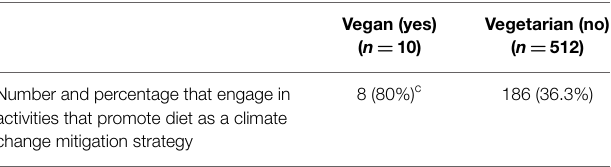
TABLE 4 | Number and percentage of survey participants that engage in activities that promote diet as a climate change mitigation strategy based upon being vegan a,b .